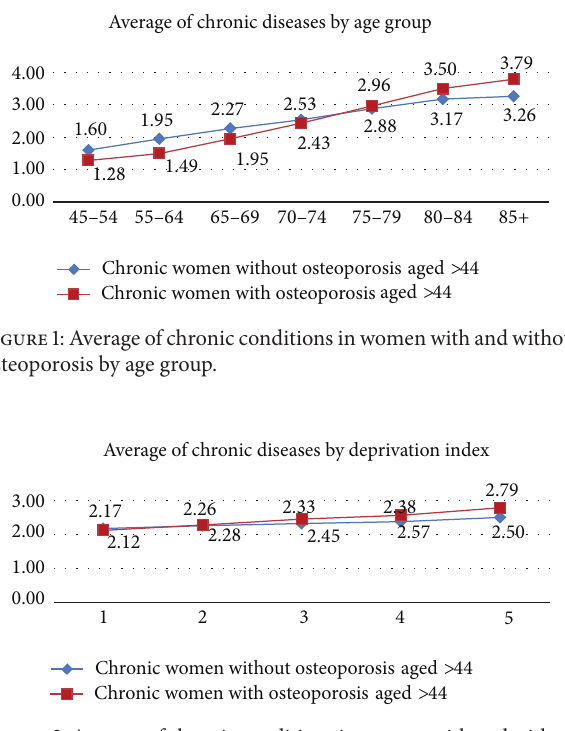
Figure 2: Average ofchronic conditions inwomen with and without osteoporosis by deprivation